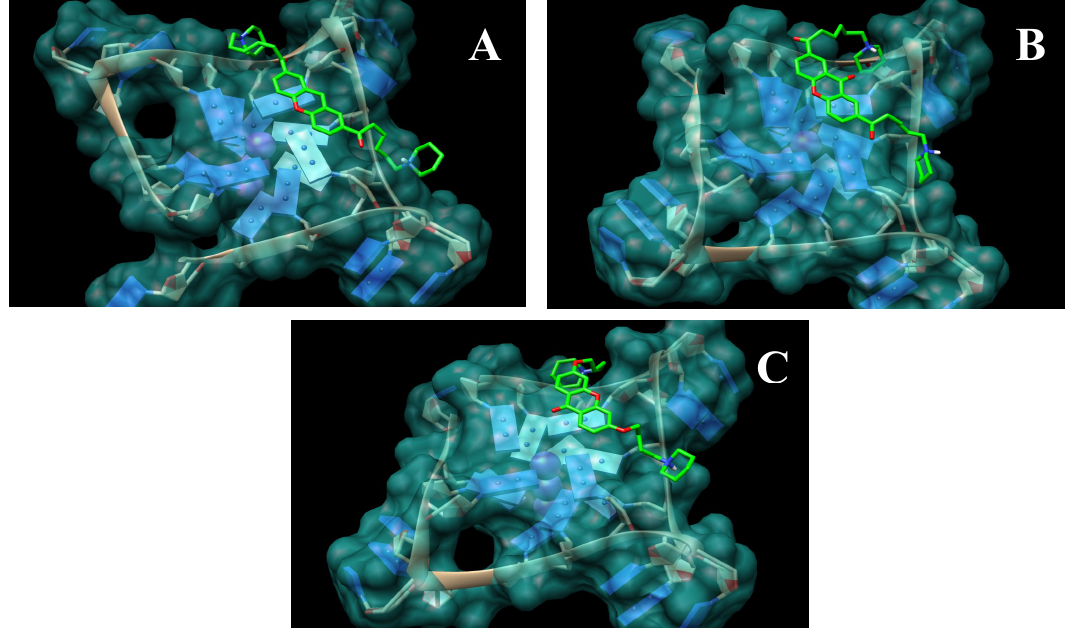
Figure 3. Models obtained for the complexes between xanthene and xanthone derivatives (atom-type coloured) and the telomeric G-quadruplex (blue) ( A ) XA2pip 3b . ( B ) XO2pip 4b . ( C ) HXO2pip 8b